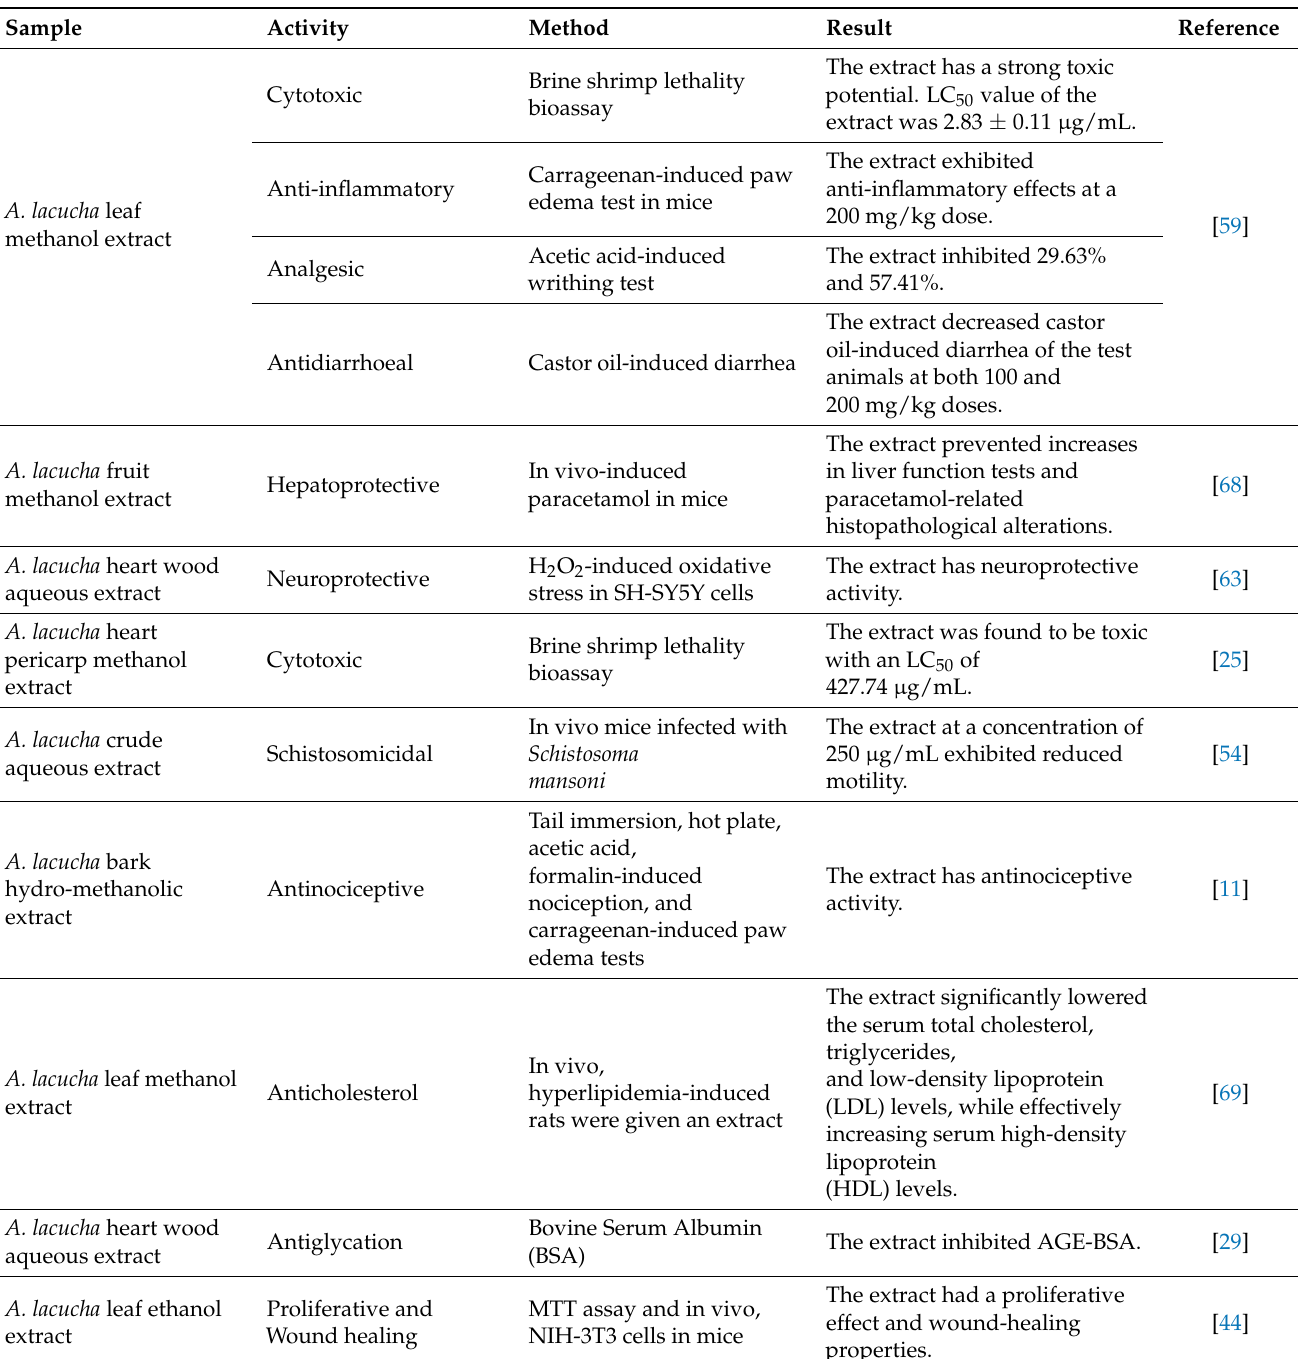
Table 4. Pharmacological activity of A. lacucha based on scientific